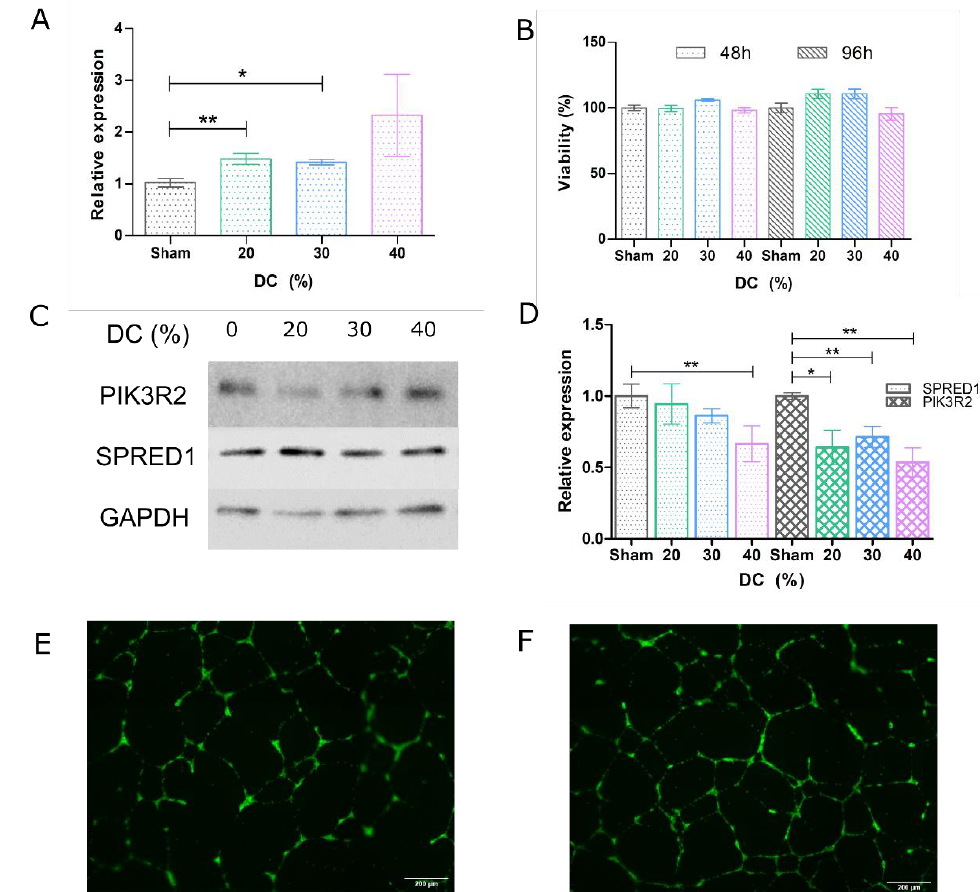
Figure 4. Ultrasound-mediated miR-126 delivery results in viable physiologically relevant treat- ment of endothelial cells. ( A ) RT-qPCR analysis of the relative miR-126 expression from treated HUVECs. ( B ) Viability assessment of the cells 48 h and 96 h following ultrasound treatment by MTT assay. ( C ) PIK3R2 and SPRED1 protein expression in treated HUVECs determined by Western blot- ting. ( D ) Aggregate relative PIK3R2 and SPRED1 expression 48 h following HUVEC treatment. ( E ) HUVEC tube formation assay, untreated and ( F ) treated at 20% DC. In aggregate, the tube network increased by 22 – 26% and exhibited a 5 – 17% increase in branching nodes. Scale bar: 200 µm. (*: p < 0.05, **: p < 0.01). Grey: sham, green: 20% DC, blue: 30% DC, magenta: 40% DC.